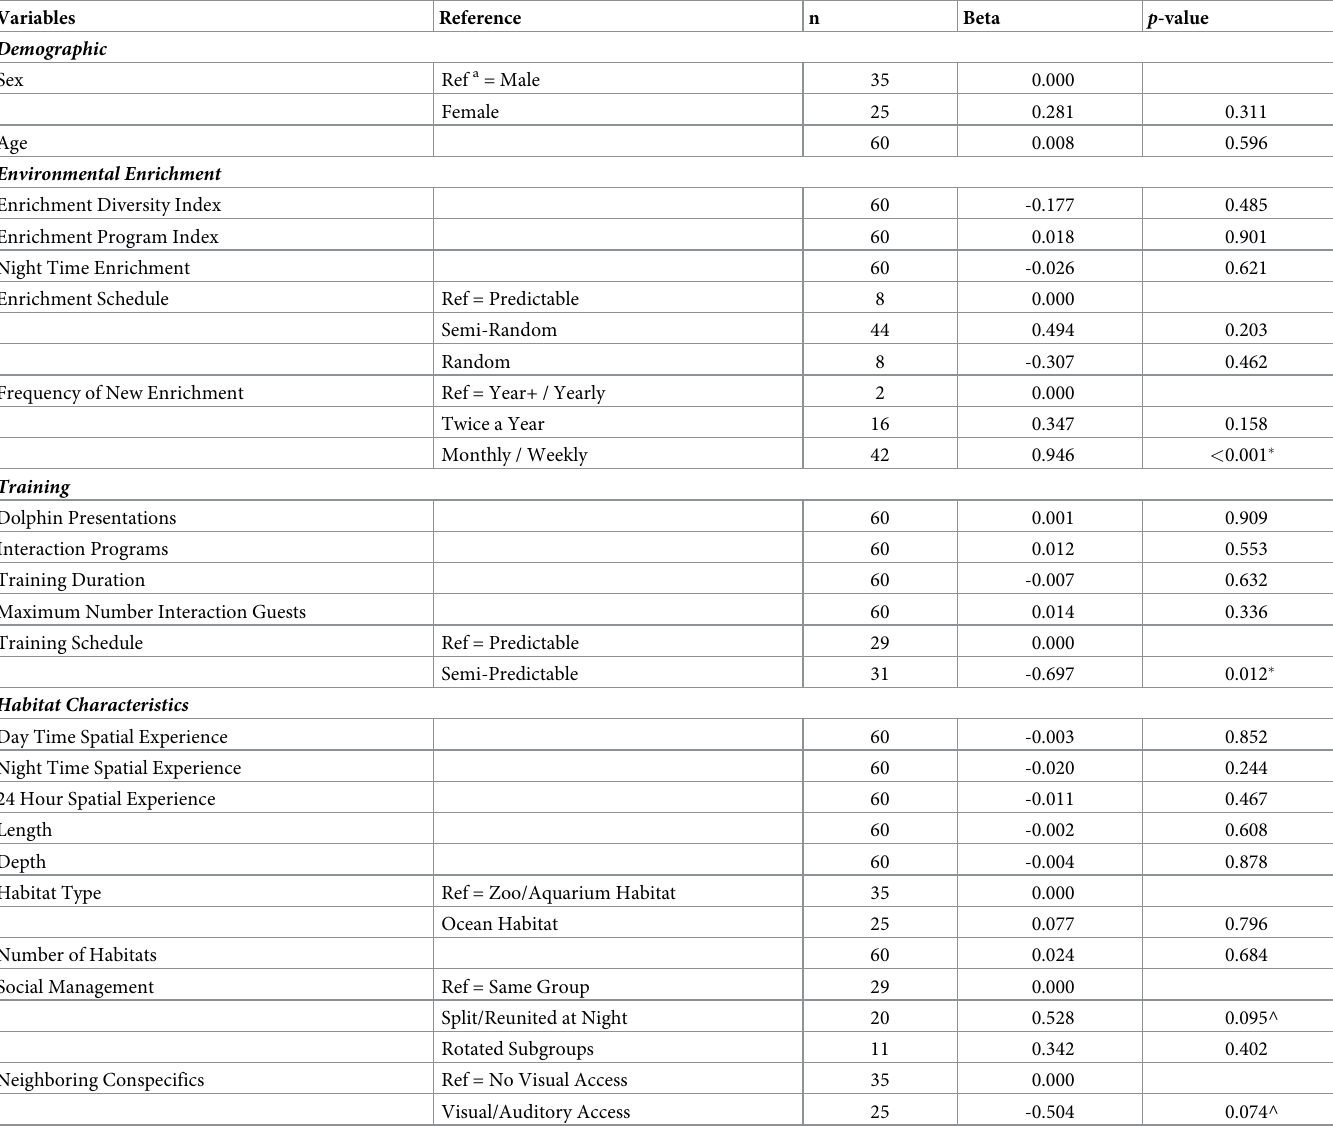
Table 3. Univariate correlations between distance traveled and independent